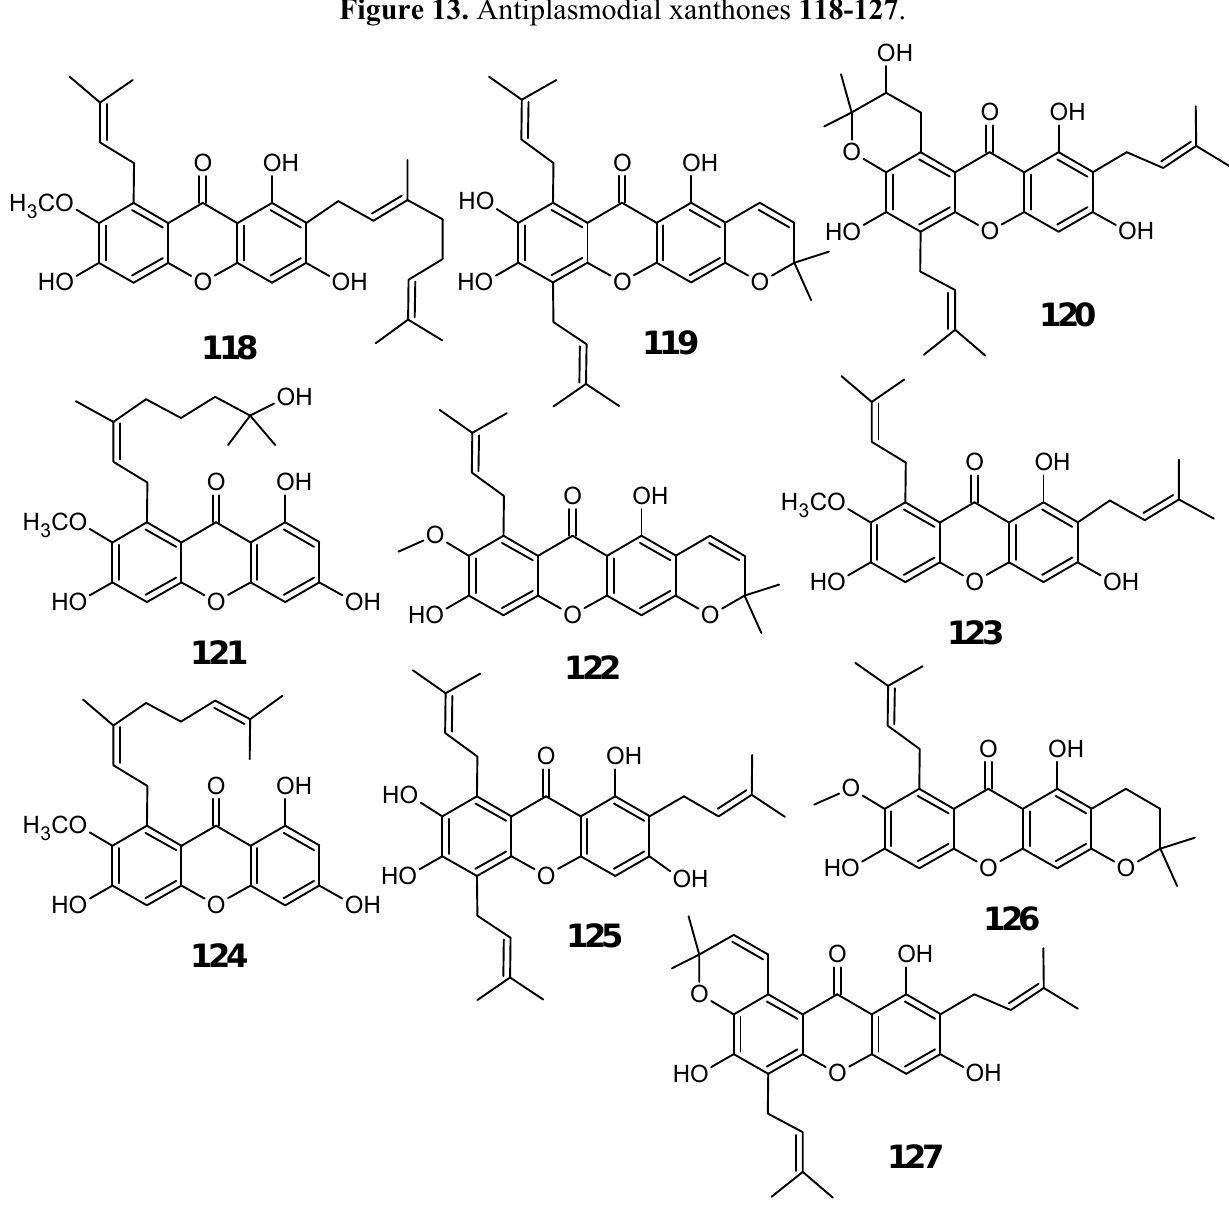
Figure 13. Antiplasmodial xanthones 118-127